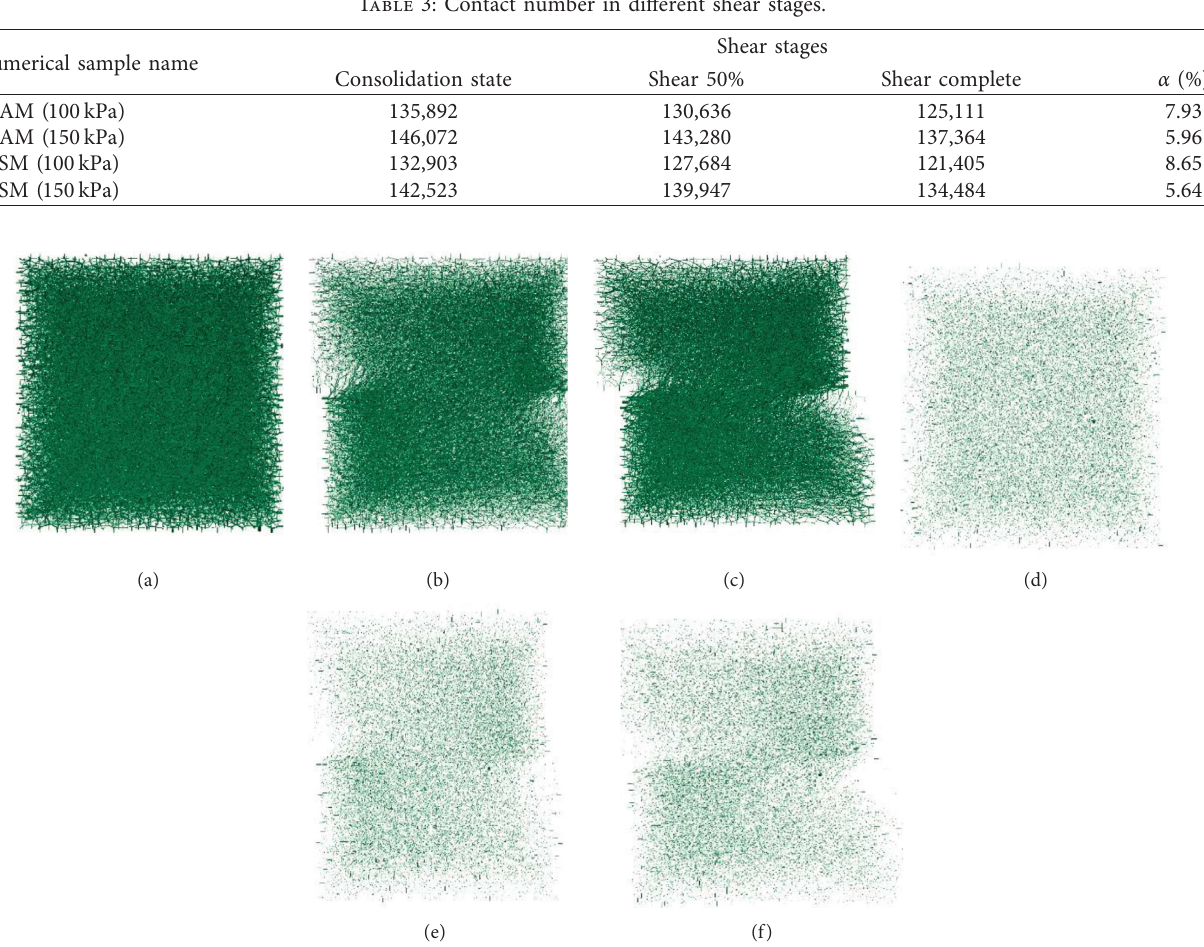
Figure 11: Contact force chain evolution of stone numerical samples with different roundness in the shear process under 100kPa normal stress. (a) RSAM consolidation state. (b) RSAM shear 50%. (c) RSAM shear complete. (d) SBSM consolidation state. (e) SBSM shear 50%. (f) SBSM shear complete.